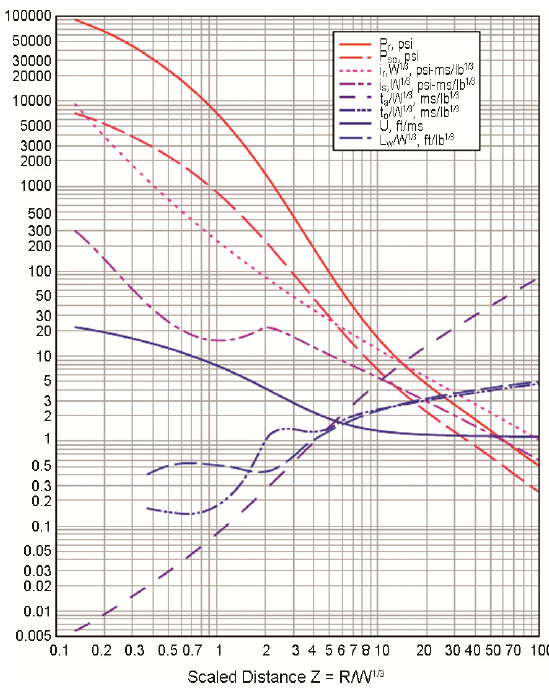
Fig. 4. Positive phase shock wave parameters for explosion in free air at sea level (UFC